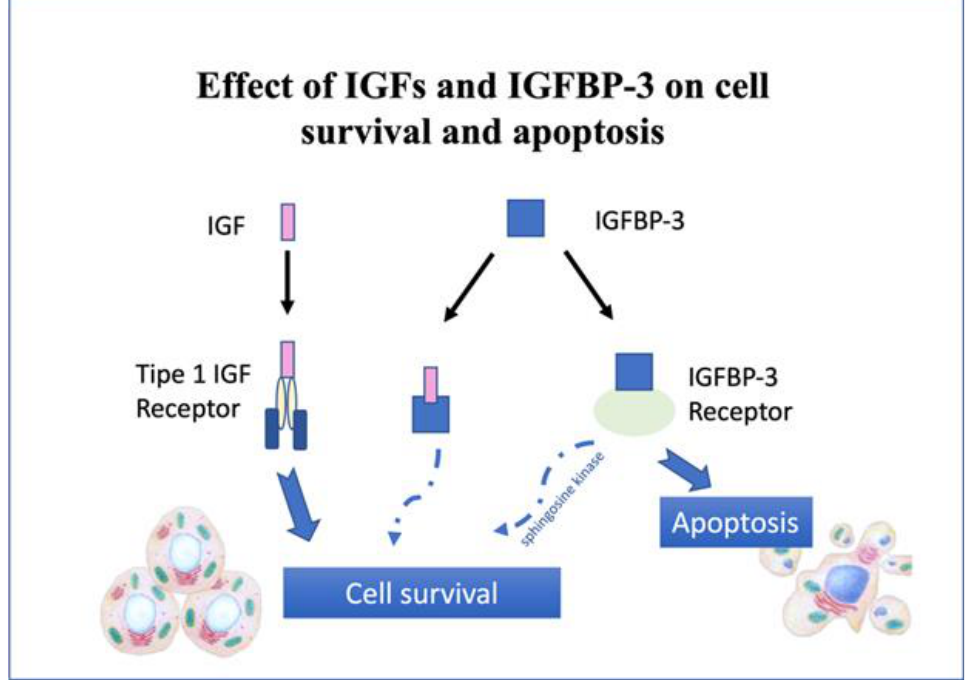
Figure 1. IGFBP-3’s and IGF’s role in Apoptosis and Cell Survival: IGFBP-3 plays double function of gate-keeper (induction of apoptosis and cell cycle arrest) and care-taker (DNA repair) through mechanisms independent of IGFs [47].